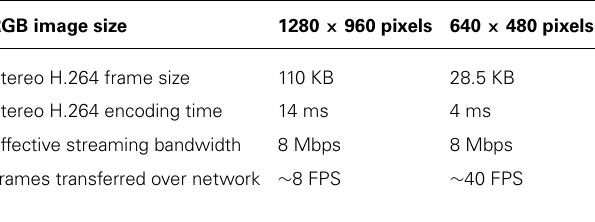
Table 3 | Remote visualization characteristics using a 100 Mbps connection with a frame rate of 30